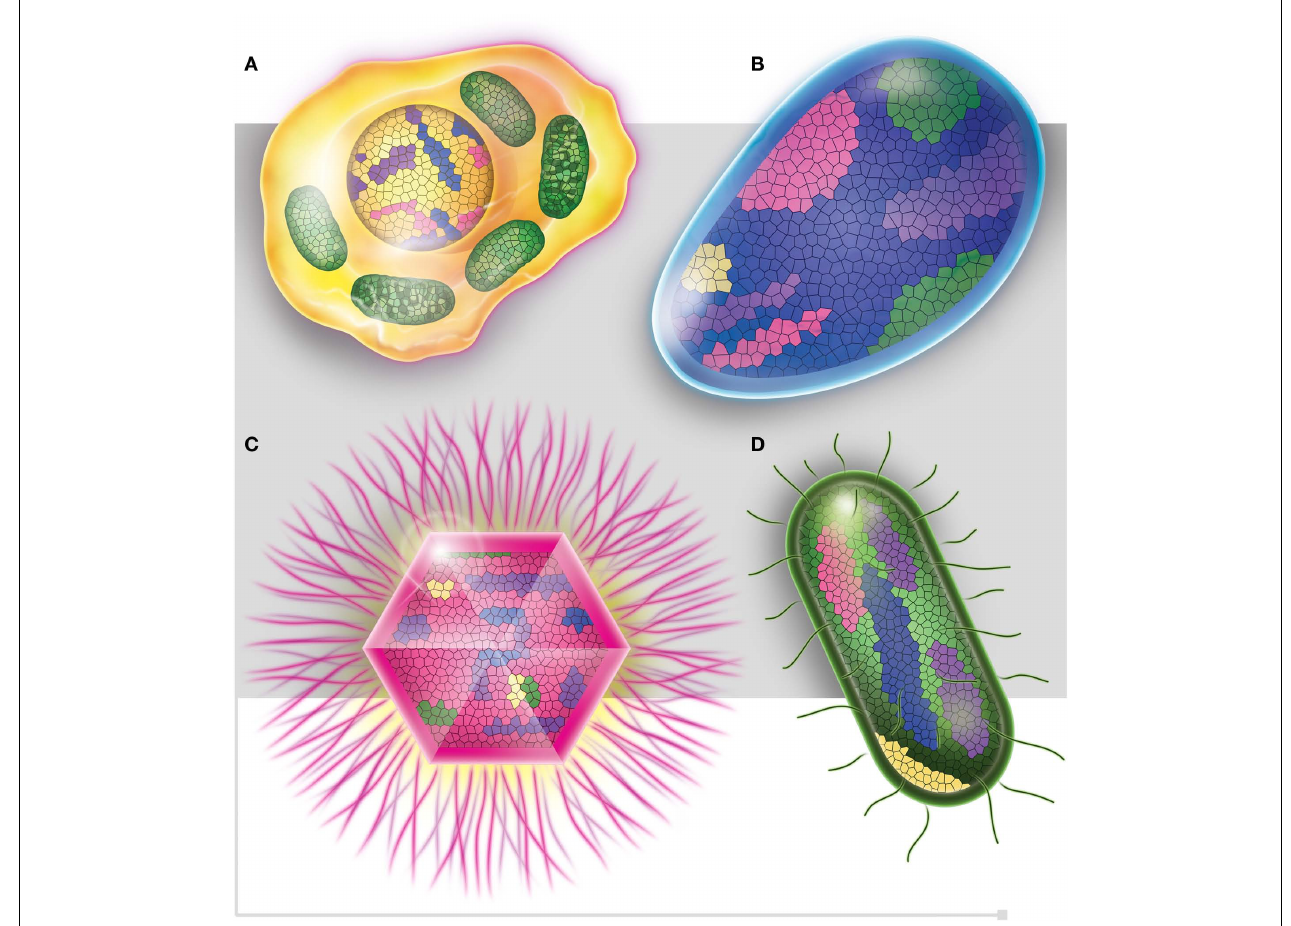
FIGURE 5 | Each one of the four domains of life, (A) Eukaryotes (in yellow), (B)Archaea (in blue), (C)Viruses (in pink), and (D) Bacteria (in green), is represented as mosaics containing genes from all four domains. Purple squares represent ORFan genes.